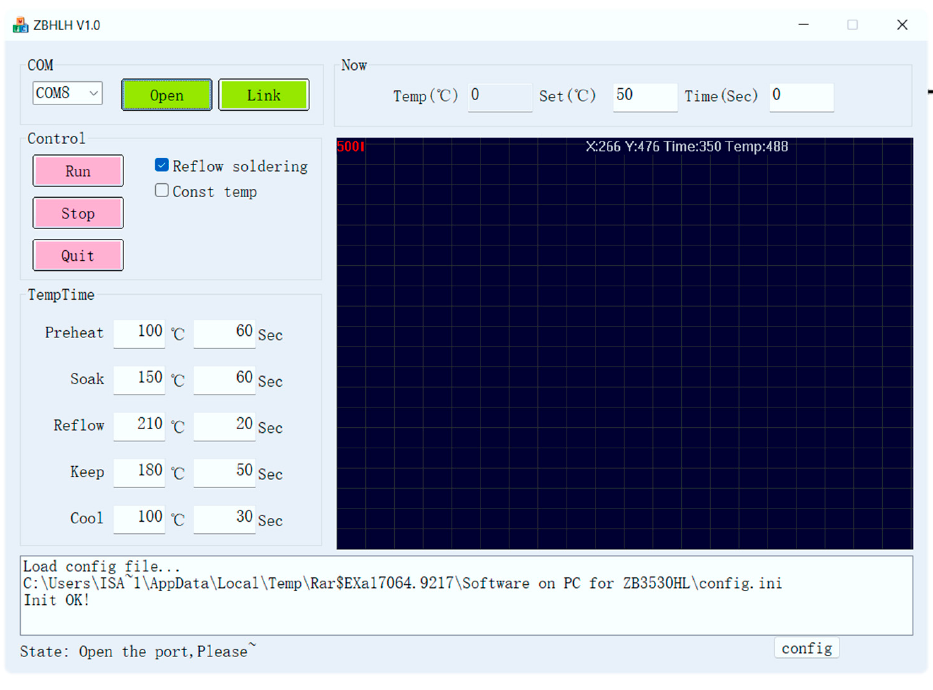
Figure 3. The Zhengbang Company Oven Control Software. Note buttons that indicate commands such as “Open”, “Link” or “Stop”. These are the necessary control outputs; each button corresponds to a specific command. The final interface is able to replicate such signals.